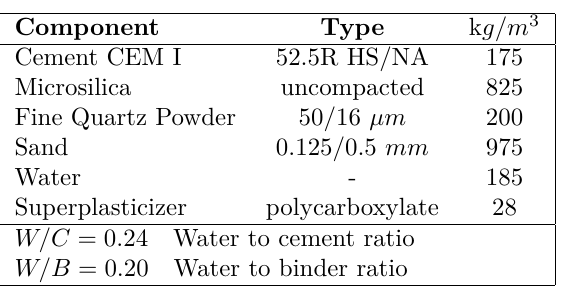
Table 1. The design of the concrete mix used.